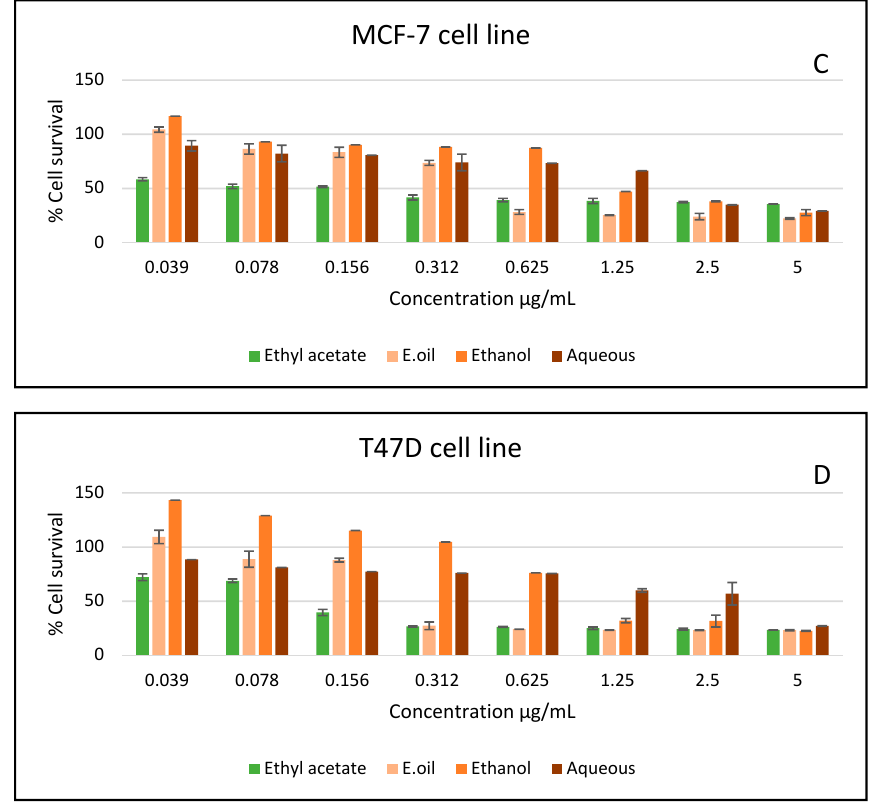
Figure 3. The antiproliferative activity of A. citrodora extracts and essential oil against different cancer cell lines: ( A ) EMT6/P, ( B ) MDA-MB231, ( C ) MCF-7, ( D ) T47D. Results are expressed as means of three independent experiments (bars) ± SEM (lines).